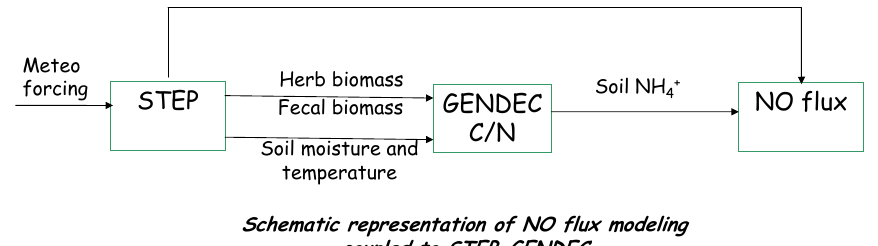
Figure 1. Schematic view of links between the STEP, GENDEC and NO emission